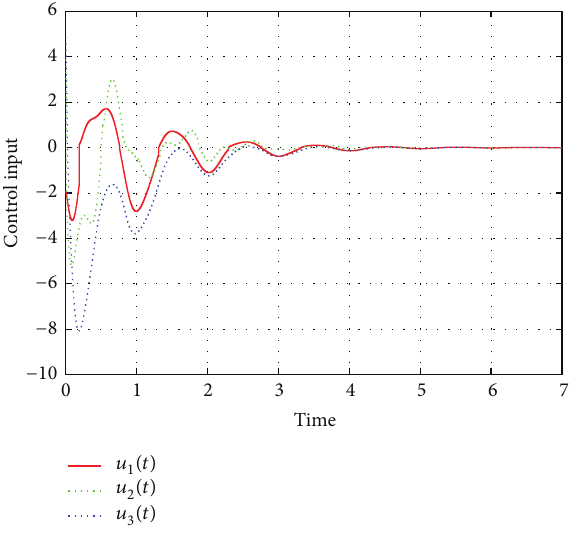
Figure 4: Time histories of 𝑢 𝑖 (𝑡)